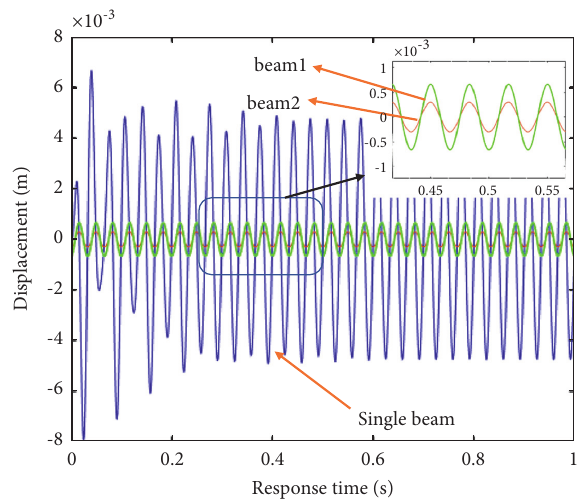
Figure 23: Comparison of the time-domain response of two beams.